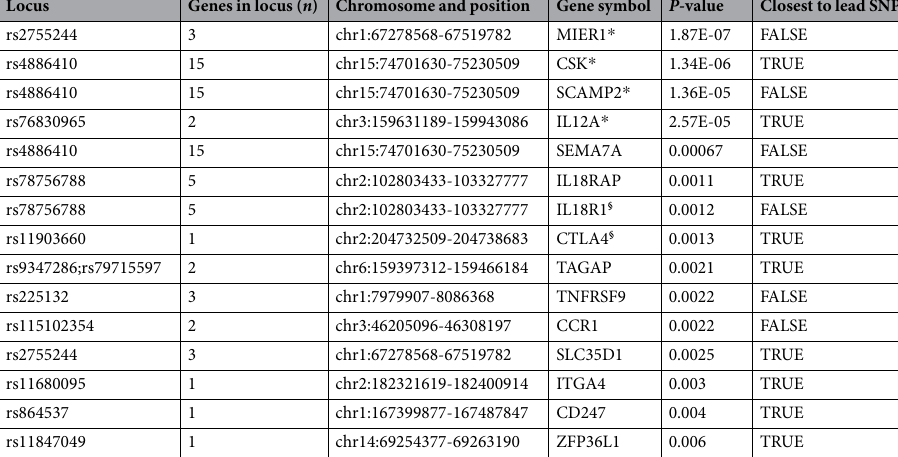
Table 3. DEPICT prioritized genes mapping onto 52 ‘top’ overlapping SNPs. Genes with FDR adjusted P -value lower than 0.05. * FDR < 0.01; § hits also found significant (FDR < 0.01) in the sensitivity analysis (66 CD-SNPs, P BC > 0.05) were considered as unreliable findings. § FDR <